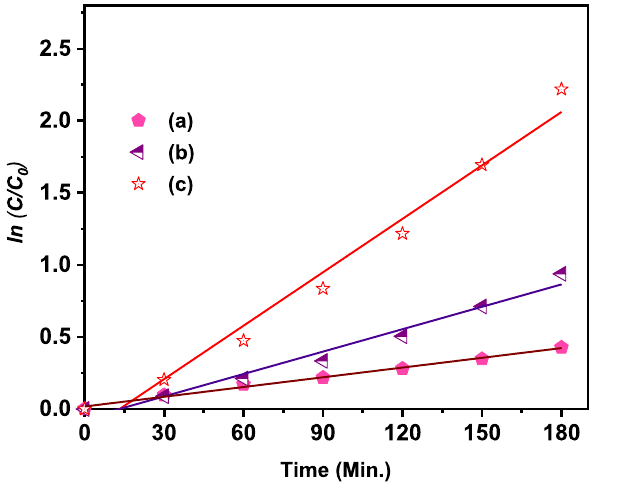
Fig. 10 First-order kinetics plot for the degradation of MB on (a) SnO 2 , (b) 2% Y-doped SnO 2 NPs and (c) 4% Y-doped SnO 2 NPs